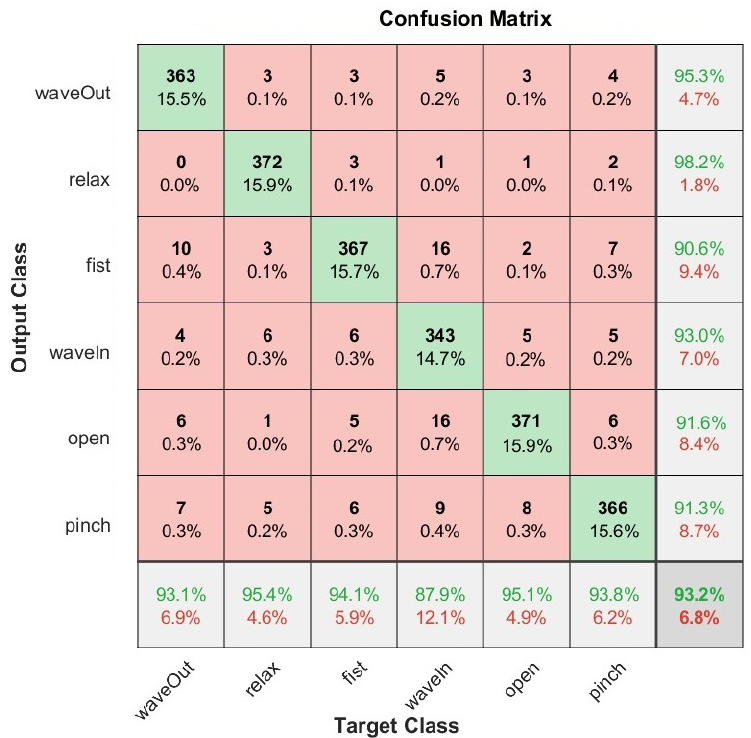
Figure 8. User-specific HGR model confusion matrix for 26 users from the test set with the best hyperparameter configuration for the Myo armband sensor for static